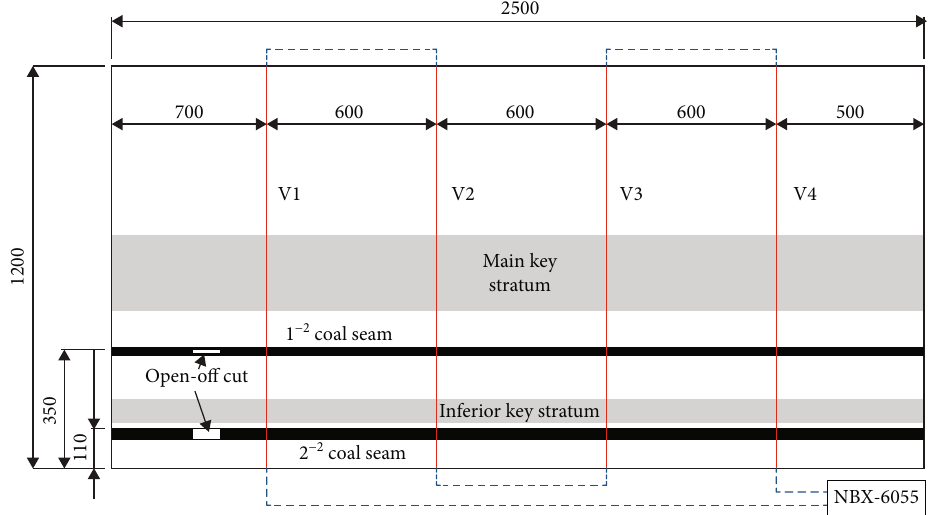
Figure 2: Layout of the distributed optical fi ber